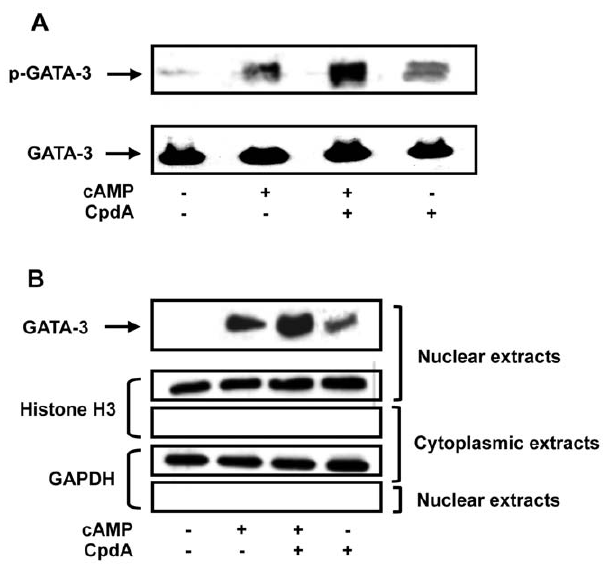
Figure 5. Compound A induces GATA-3 phosphorylation and nuclear translocation. A, EL4 cells were transfected with 15 m g of the GR and 15 m g of GATA-3 expression vectors. After 16 h in culture, EL4 cells were pretreated during 30 minutes with or without Compound A (CpdA, 10 m M) and then treated under basal or activated conditions using cAMP (0.3 mM) during 25 minutes. Cell lysates were prepared for Western Blot analysis against phospho-GATA-3 (p-GATA-3) (bands of 55 kDa). Total GATA-3 signal was used as loading control. One out of three independent experiments with similar results are shown. B, EL4 cells were transfected with 15 m g of the GR and 15 m g of GATA-3 expression vectors. After 16 h in culture, EL4 cells were pretreated during 30 minutes with or without CpdA (10 m M) and then treated under basal or activated conditions using cAMP (0.3 mM) during 25 minutes. Cell nuclear and cytoplamic extracts were prepared for GATA-3 analysis by Western Blot. Histone H3 and GAPDH signals were used as nuclear and cytoplasmic extracts control respectively. One out of three independent experiments with similar results are shown.